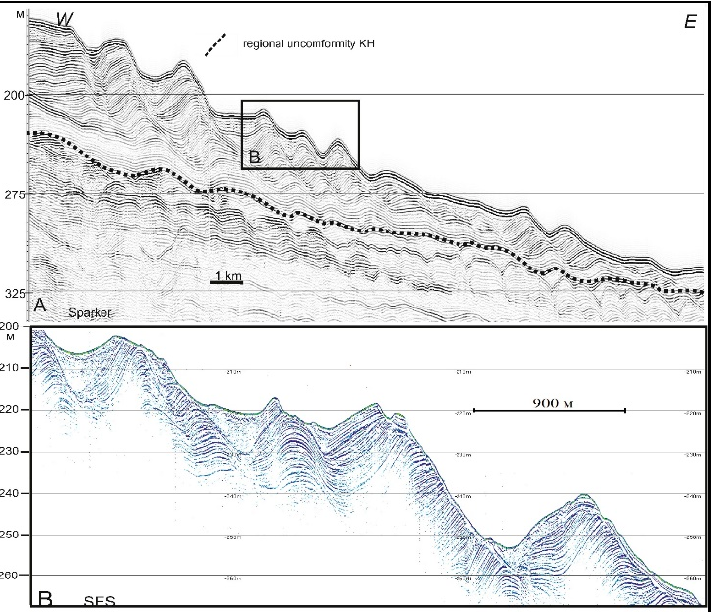
Figure 5. Sediment waves of turbidity + contourite genesis on the western slope of the Derbent Basin. ( A ) Fragment of the profile (sparker) from Figure 4A. KT—regional unconformity Khvalinian transgression. ( B ) Enlarged fragment of ultra-high-resolution seismic reflection profile (SES) showing in detail uppermost sedimentary layer with evidence of the young to present-day erosion activity.